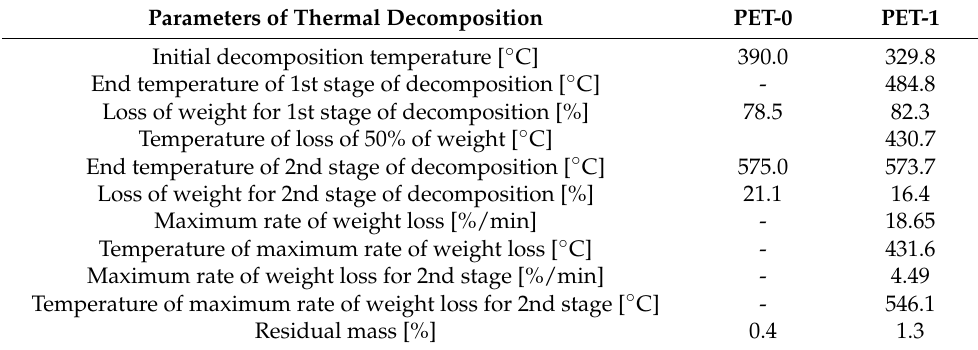
Table 4. Selected parameters for the thermal decomposition process for PET-0 and